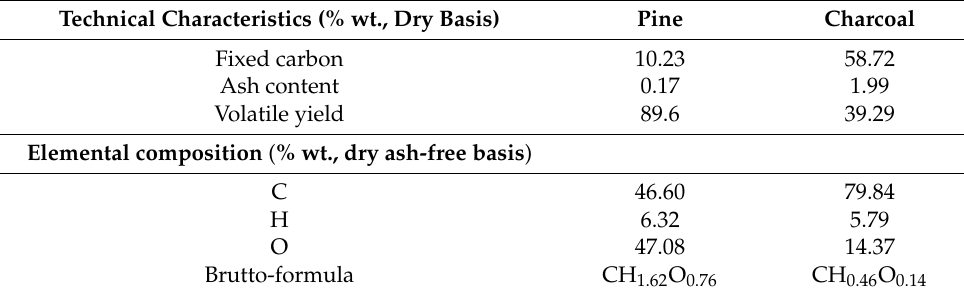
Table 1. Technical specifications of raw wood and charcoal.